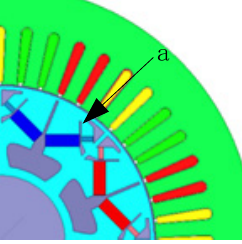
Figure 4. Lengthened magnetic barrier.